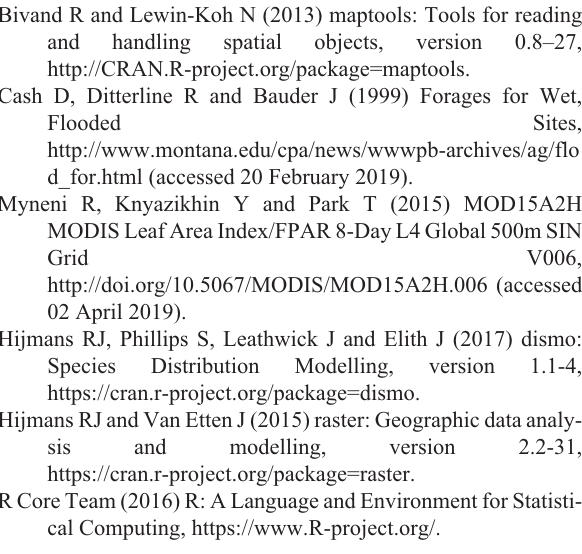
Figure S1 - Linkage disequilibrium plots of progenies. Figure S2 - PCA indicating the contribution of each envi- ronmental variable for the observed distribution of Paspalum modestum . Figure S3. Species distribution model prediction. Table S1 - List of Paspalum modestum localities used for ecological niche